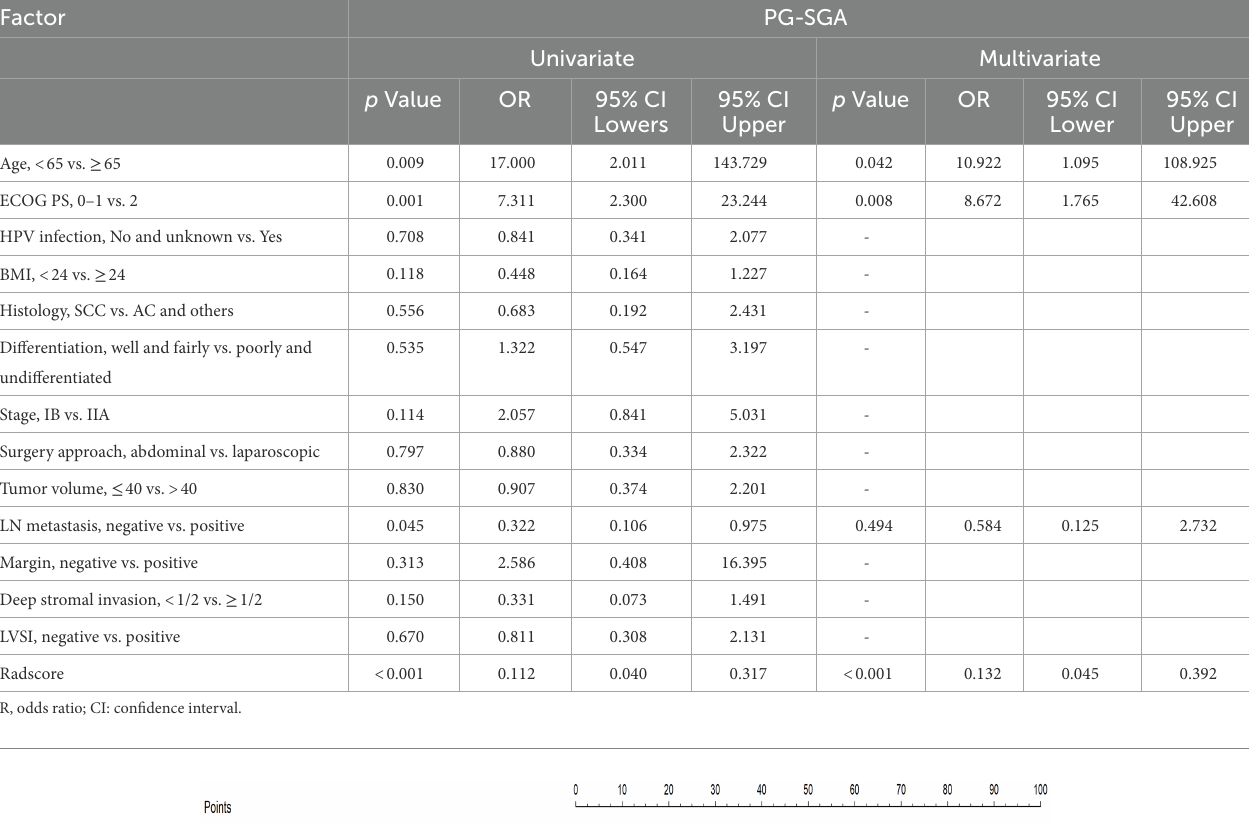
TABLE 2 Univariate and multivariate analyses to predict malnutrition using a binary logistic regression